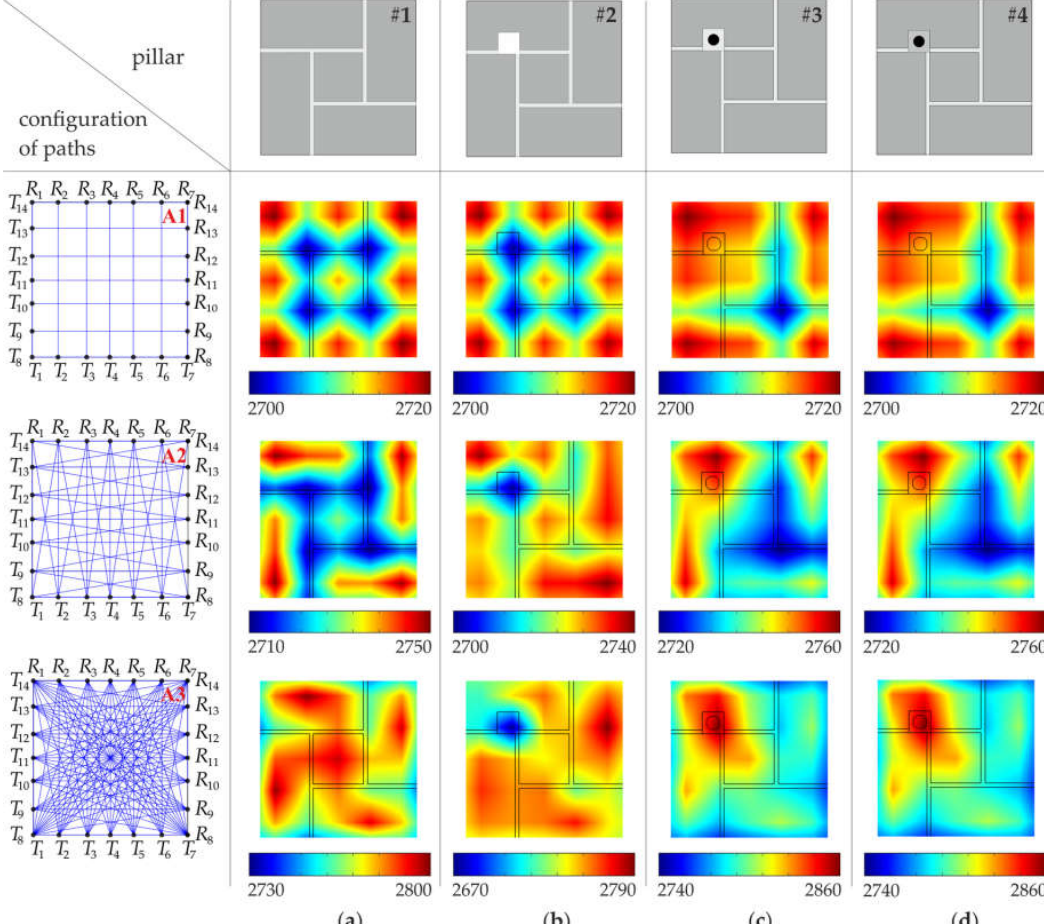
Figure 7. Tomographic velocity images (values in (m/s)), with a division into 49 pixels (configuration #A), obtained from FEM signals: ( a ) intact pillar; ( b ) pillar with the square hole; ( c ) pillar with the